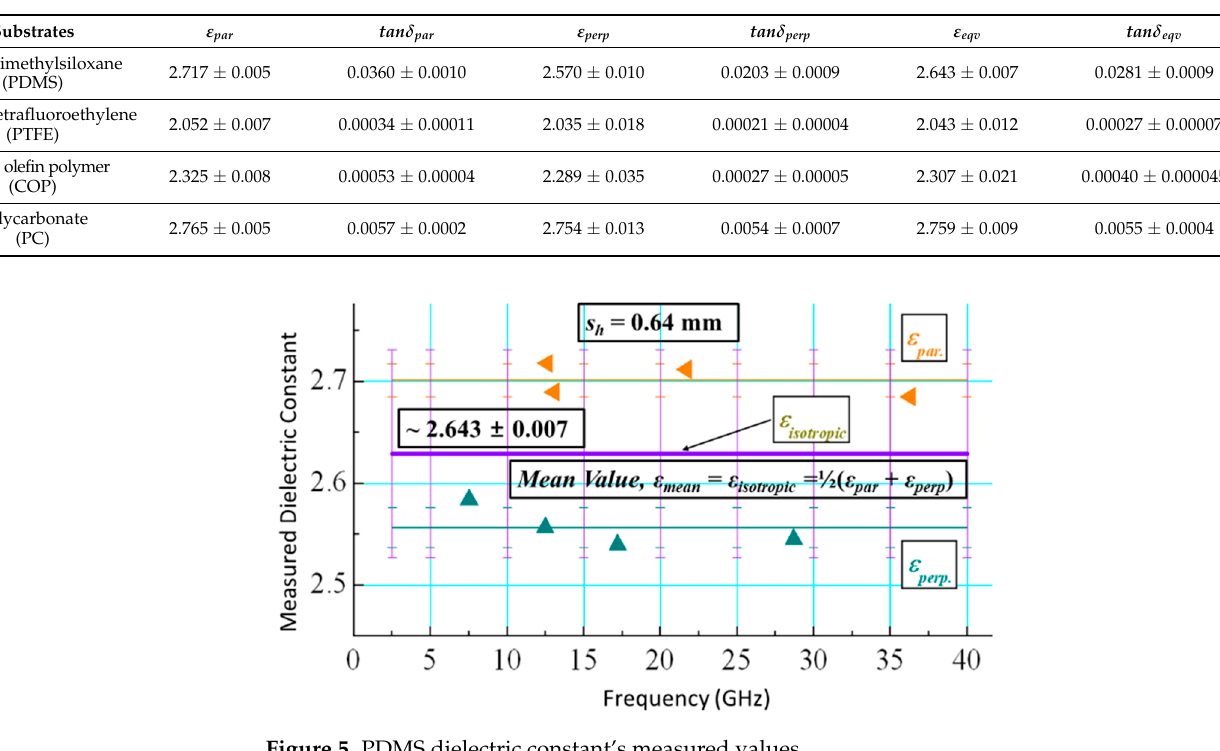
Table 3. Comparison of PDMS dielectric parameters with other similar materials evaluated using the same method.